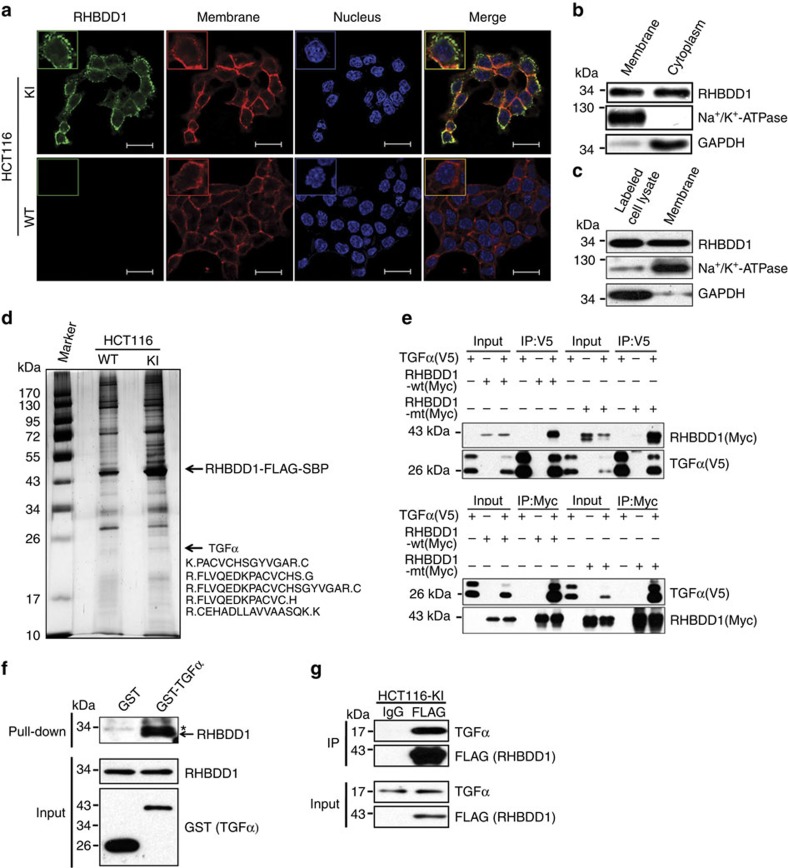
RHBDD1 is physically associated with proTGFα.(a) Immunofluorescence staining for RHBDD1 localization. RHBDD1 localization was analysed by immunofluorescence with anti-FLAG antibody (green). Cell membranes and nuclei were stained with Alexa Fluor 594 WGA (red) and DAPI (blue), respectively (scale bars, 22 μm). (b) Western blot analysis of isolated plasma membrane and cytosolic proteins in wild-type HCT116 cells to determine RHBDD1 localization. Na+/K+-ATPase and GAPDH were used as a plasma membrane marker and a cytosolic marker, respectively. (c) Western blot analysis of isolated cell surface proteins in wild-type HCT116 cells to determine the plasma membrane localization of RHBDD1. Na+/K+-ATPase and GAPDH were used as a plasma membrane marker and a cytosolic marker, respectively. (d) The affinity purification and Mass spectrometry analysis of RHBDD1-associated proteins. (e) Co-immunoprecipitation assays for RHBDD1 and proTGFα. proTGFα-V5 was transfected into HEK 293T cells with RHBDD1-Myc or its inactive mutant. The immune complexes (IP) and 5% input were analysed by immunoblotting with anti-Myc or anti-V5 antibody. (f) GST pull-down assays for RHBDD1 and proTGFα. HCT116 cell lysates were incubated with GST and GST-proTGFα fusion proteins. The GST pull-down products were analysed by immunoblotting with anti-RHBDD1 antibody. The asterisk indicates a nonspecific band. (g) Immunoprecipitation assays for RHBDD1 and proTGFα. Cell lysates from targeted knock-in HCT116 cells were immunoprecipitated with anti-FLAG antibody or control IgG. The immune complexes (IP) and 5% input were analysed by immunoblotting with anti-proTGFα or anti-FLAG antibody.